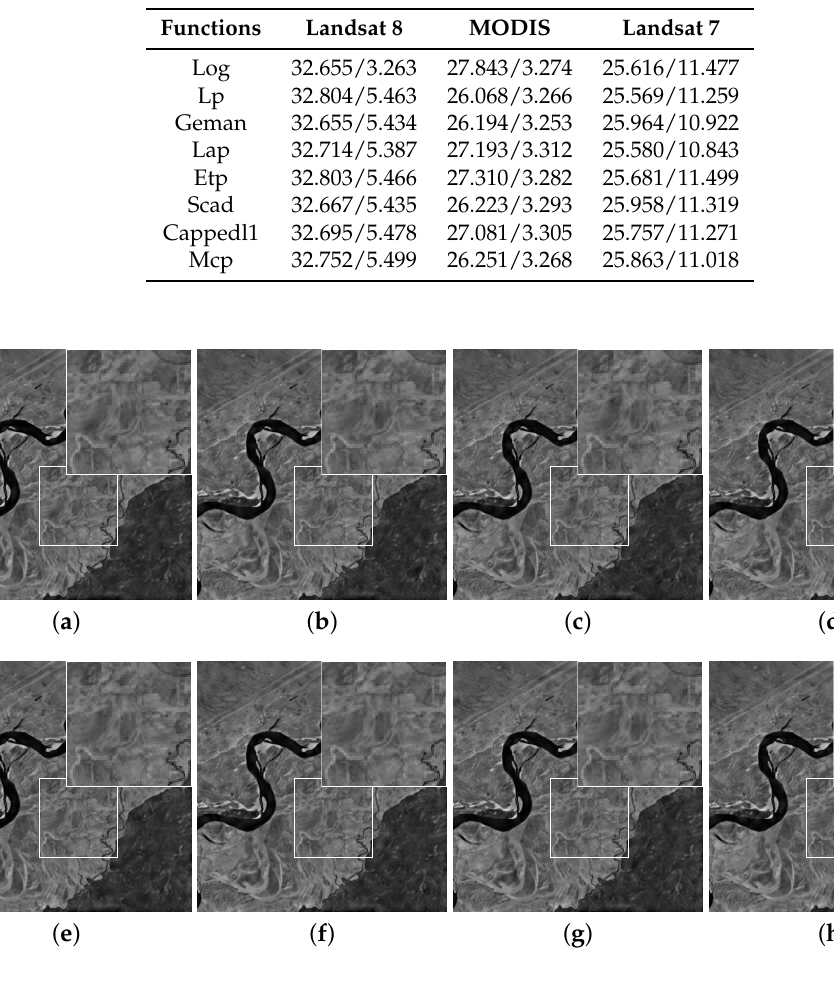
Figure 5. Reconstructed images with different nonconvex surrogate functions. ( a )